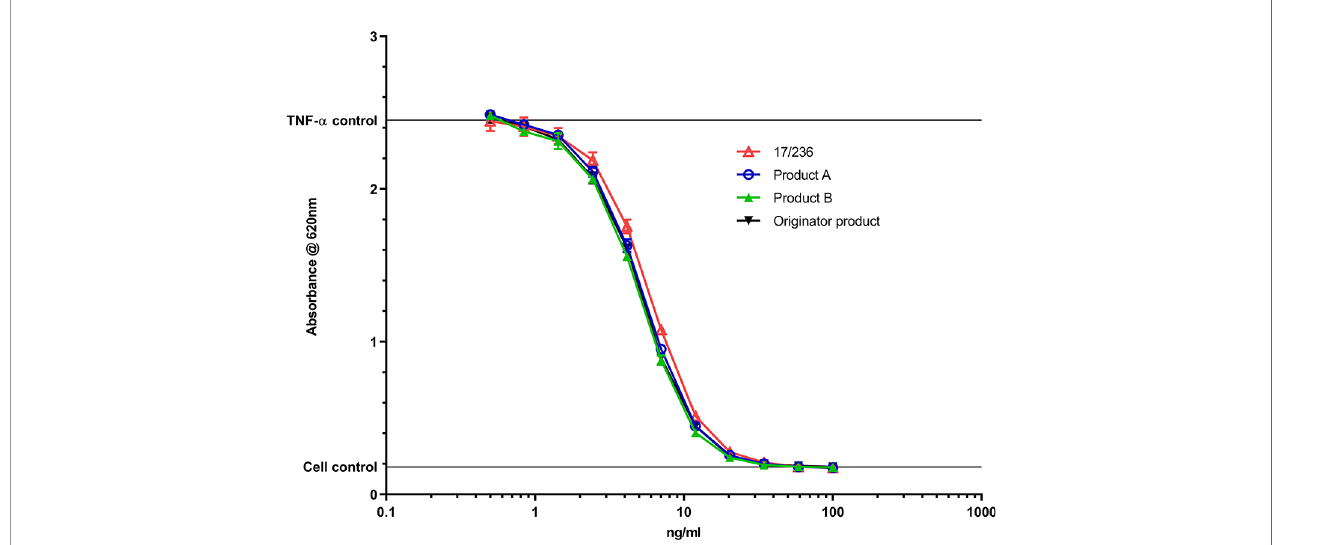
FIGURE 3 | Comparison of TNF- a neutralization activity of the IS 17/236 with 2 biosimilar adalimumab products (a single batch) and the originator product in a HEK Blue CD40L reporter gene assay. Product A – Hulio ® ; Product B – Hyrimoz ® . A fi xed concentration of 40IU/ml of TNF- a IS (12/154) was used in the